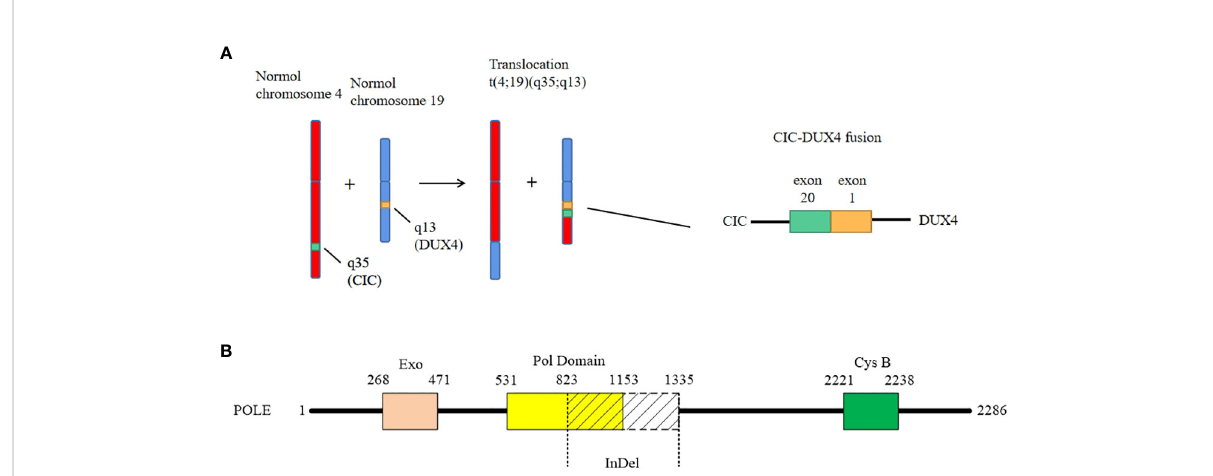
FIGURE 3 The genetic changes of the case. (A) The case shows a classical fusion of CIC – DUX4 , which is generated by translocation of chromosome t (4;19)(q35;q13). The breakpoints are located in exon 20 of CIC and exon 1 of DUX4 , respectively. (B) The LongInDel of POLE (exon22_exon31del) causes deletion of amino acid residues 823 – 1,335 of POLE protein, which may lead to frameshift and loss of polymerase domain 25 and CysB motif (amino acid residues 2,221 –